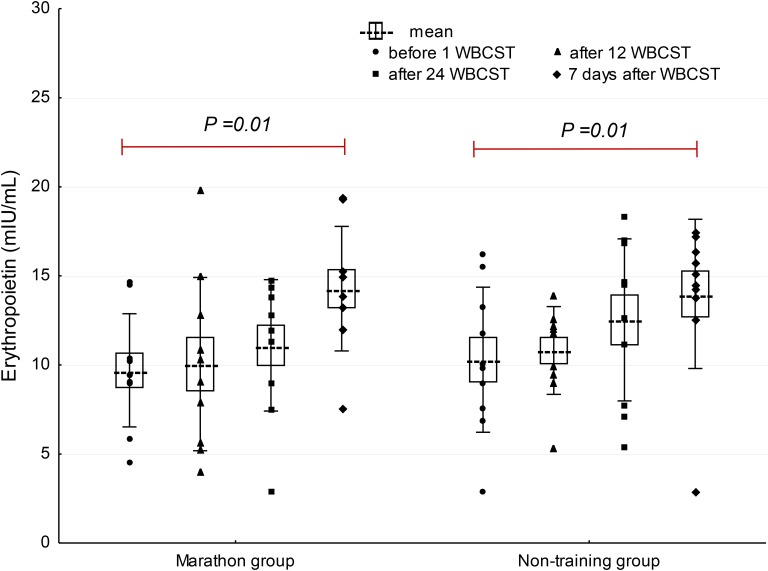
The influence of repeated whole-body cryostimulation (WBCST) treatments on the blood plasma concentration of erythropoietin in marathon runners and non-training men. Presentation of individual data, mean (---), SE (box), and SD (whiskers).